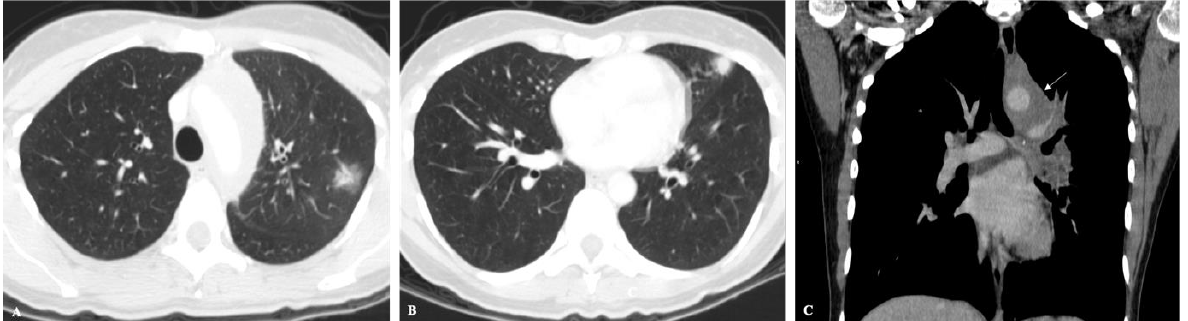
Figure 1. ( A , B ) Axial CT images showing peripherally located solid nodules with ground-glass halo in the upper left lobe, in a patient with acute histoplasmosis infection. ( C ) Coronal CT image depicts left mediastinal and hilar enlarged lymph nodes (arrow).